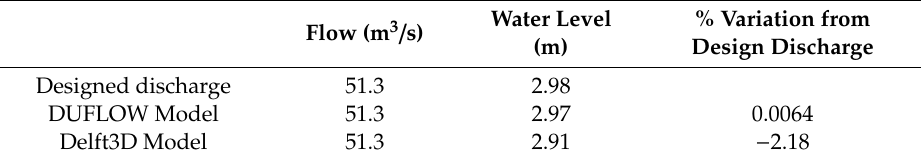
Table 3. Water level obtained from various sources at an observation point.